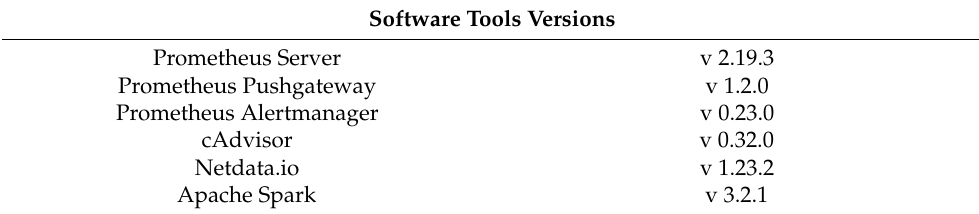
Table 3. Open-source monitoring and analysis